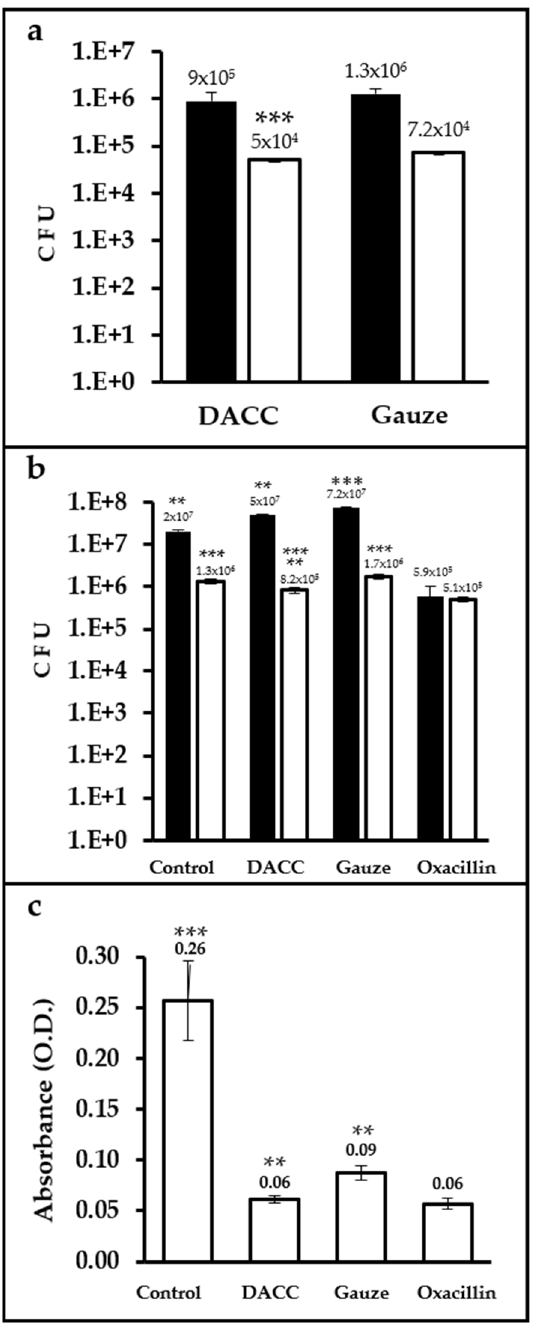
Figure 2. Quantification of CFUs and residual biomass in S. aureus cultures under different treatments: ( a ) Logarithms of mean CFUs of S. aureus retained in the dressings. The bacteria were cultured in Müller-Hinton broth (black bars) or supplemented DMEM (white bars); ***, p < 0.001 DACC vs. gauze, cultured in DMEM. ( b ) Logarithms of mean CFUs of S. aureus in the supernatants of cultures; **, p < 0.01 control vs. gauze, DACC vs. oxacillin; ***, p < 0.001 gauze vs. oxacillin, cultured in Müller-Hinton; **, p < 0.01 DACC vs. oxacillin; ***, p < 0.001 control vs. DACC, gauze, and oxacillin; DACC vs. gauze; and gauze vs. oxacillin, cultured in DMEM. ( c ) Mean of the residual biomass in the bottom of the well from the S. aureus cultures grown in DMEM. **, p < 0.01 DACC vs. gauze, gauze vs. oxacillin; ***, p < 0.001 control vs. DACC, gauze, and oxacillin. Error bars represent standard